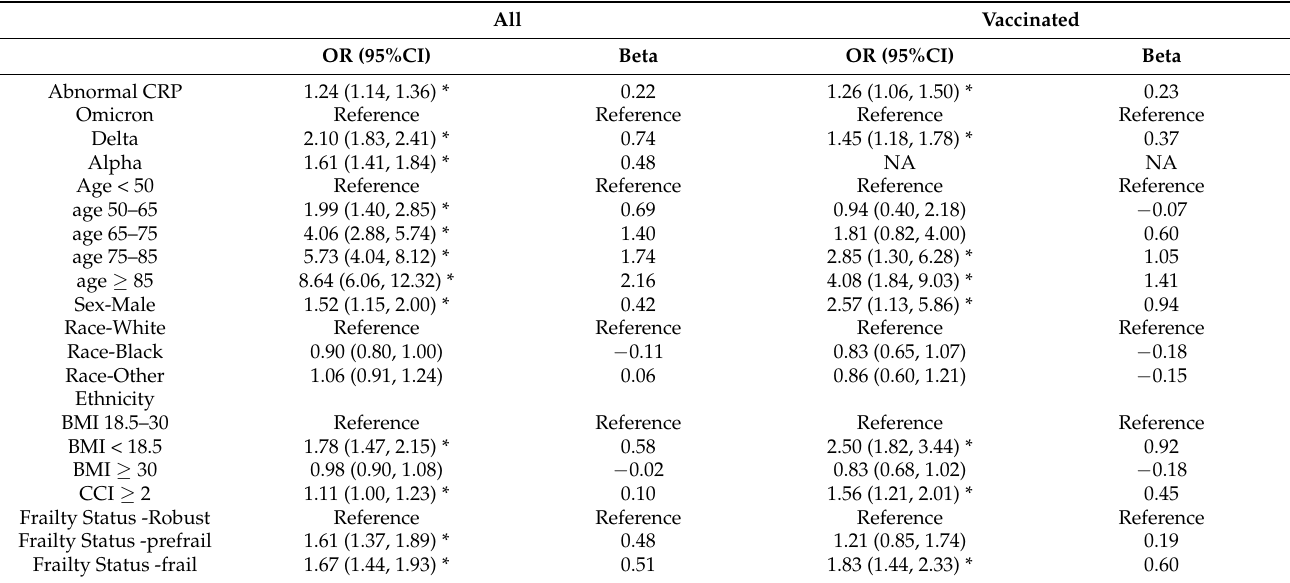
Table 4. Results of multivariate logistic regression for 14,916 patients with reported C-Reactive Protein laboratory